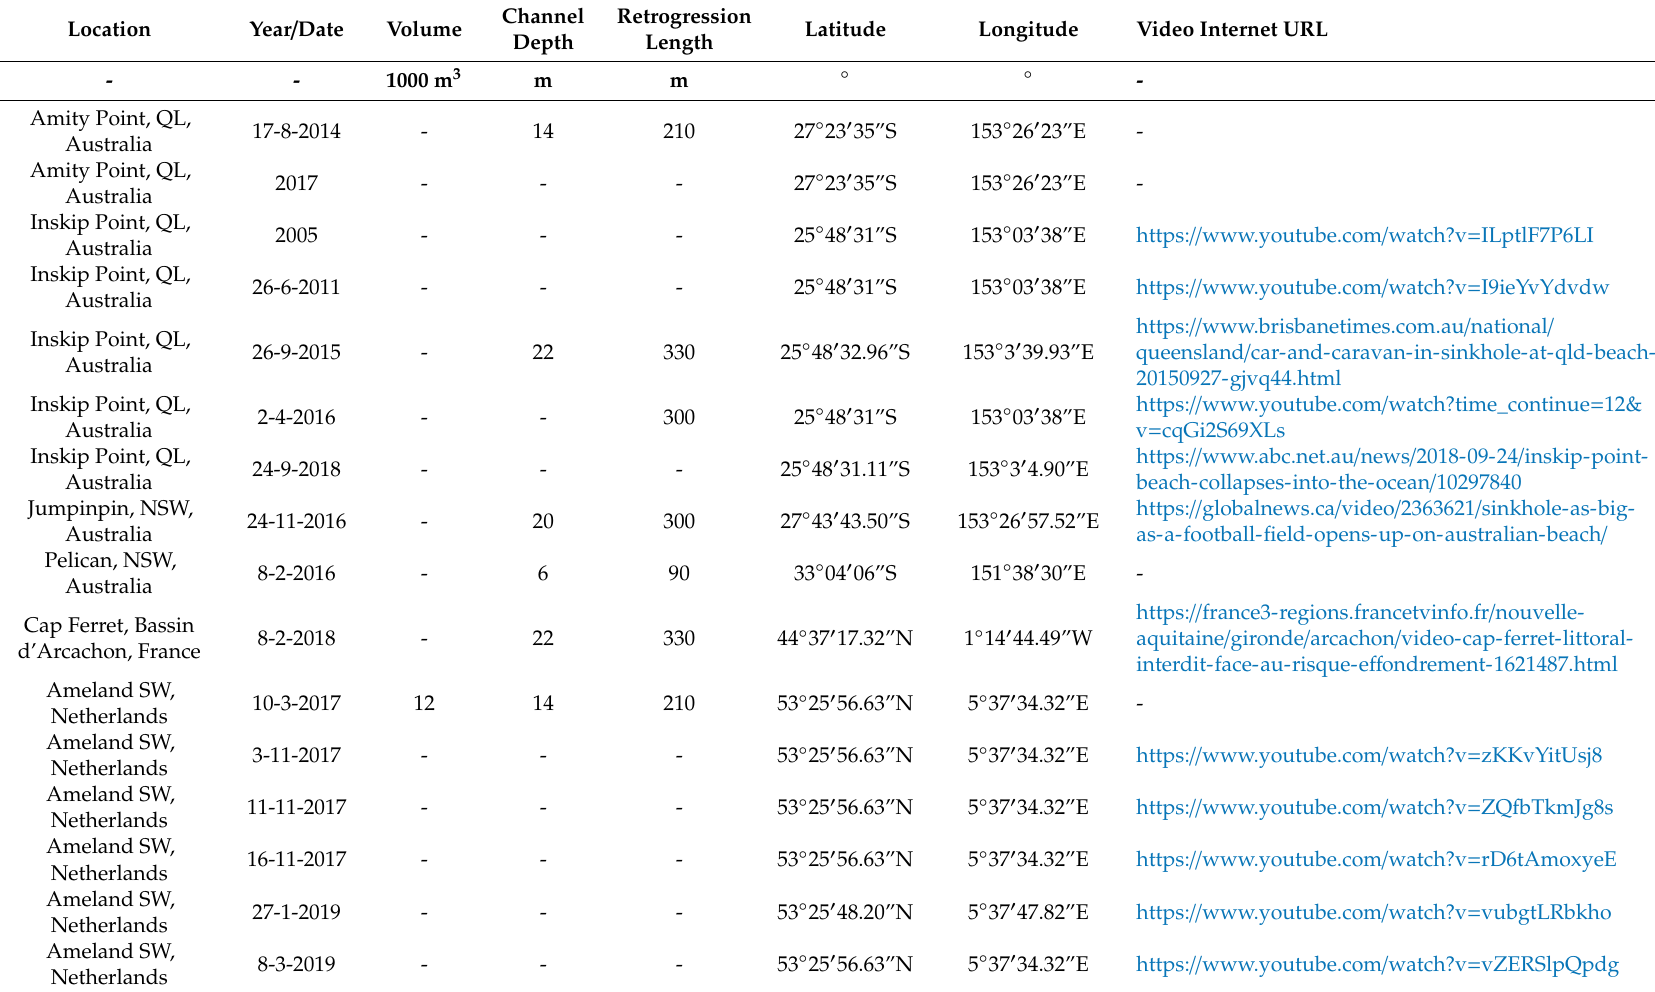
Table 1. Overview of RBF events with date, characteristic dimensions, location and video internet